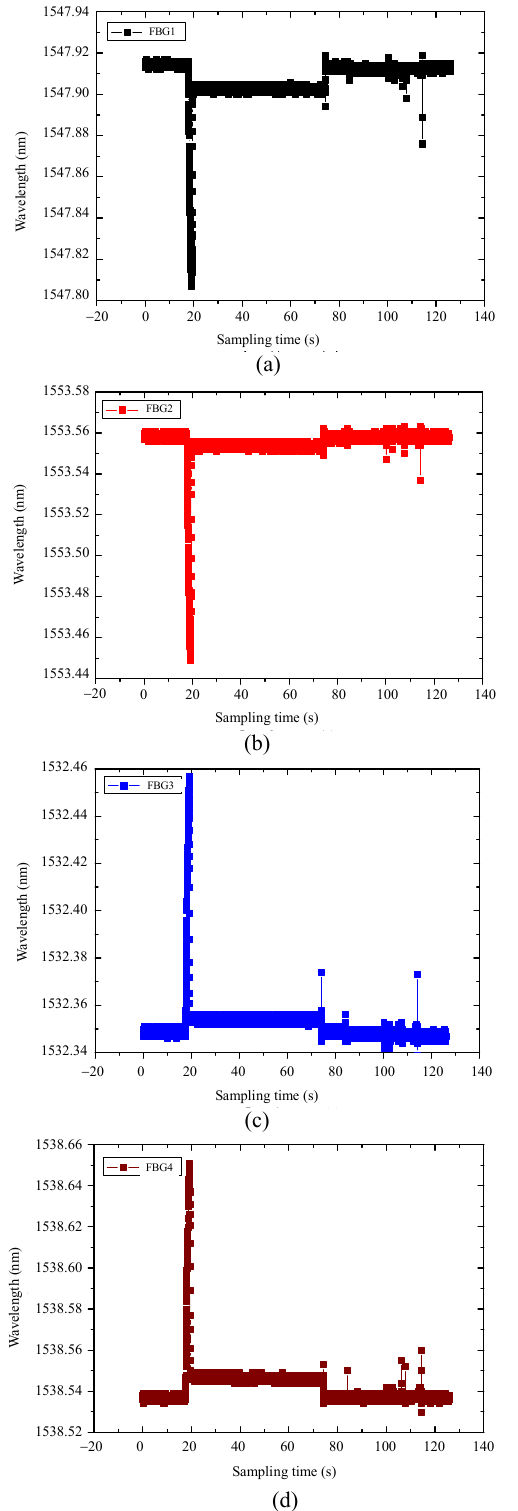
Fig. 9 Wavelength time travel curves of the four FBG sensors under impact load: (a) wavelength time travel curve of FBG1, (b) wavelength time travel curve of FBG2, (c) wavelength time travel curve of FBG3, and (d) wavelength time travel curve of FBG4.